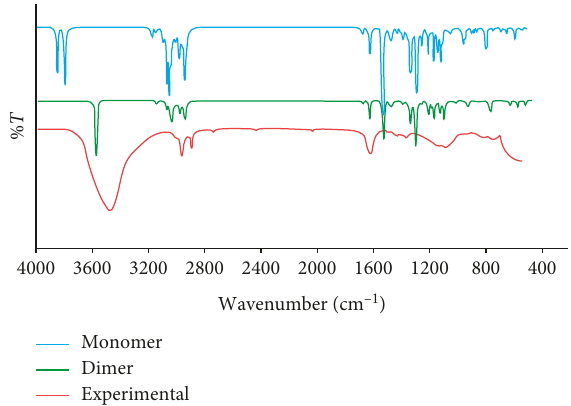
Figure 6: Comparison between experimental and calculated spectra of 4NRC.